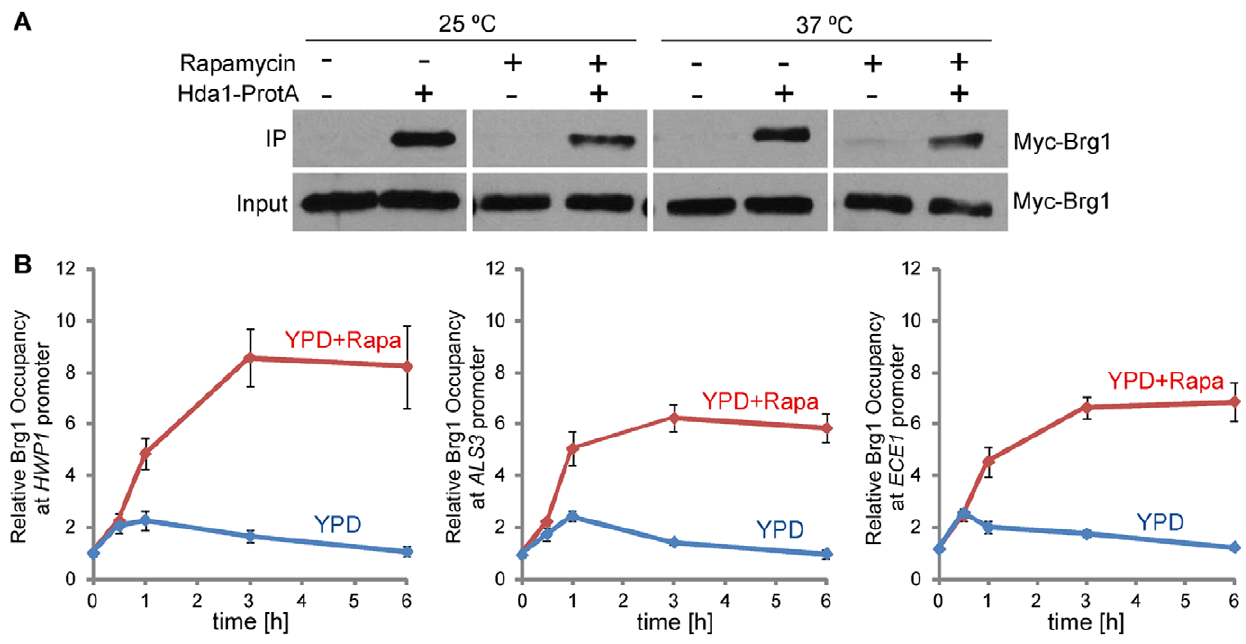
Figure 2. Brg1 interacts with Hda1 invivo and binds to promoters of hypha-specific genes. (A). Cells of wild type transformed with Myc- Brg1 and Hda1-Protein A (HLY4081) or with only Myc-Brg1 (HLY3636) were grown in YEPMaltose medium at 25 u C or 37 u C in the presence or absence of 10 nM rapamycin. Protein lysates were subjected to immunoprecipitation with IgG beads (Sigma). The precipitated proteins (IP) and cell lysates (input) were analyzed by Western blotting. (B). Brg1 is present at the HWP1 promoter in a rapamycin-containing medium. Cells of wild-type strain carrying Brg1-Myc (HLY4082) were diluted into YPD medium at 37 u C in the presence or absence of 10 nM rapamycin. ChIP DNA was quantitated by qPCR as described in Figure 1. The ChIP data show the average of three independent qPCR experiments with error bars representing the